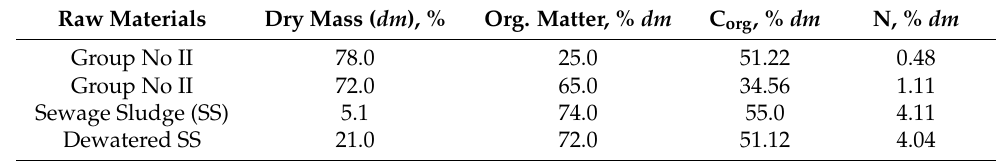
Table 6. Physicochemical test